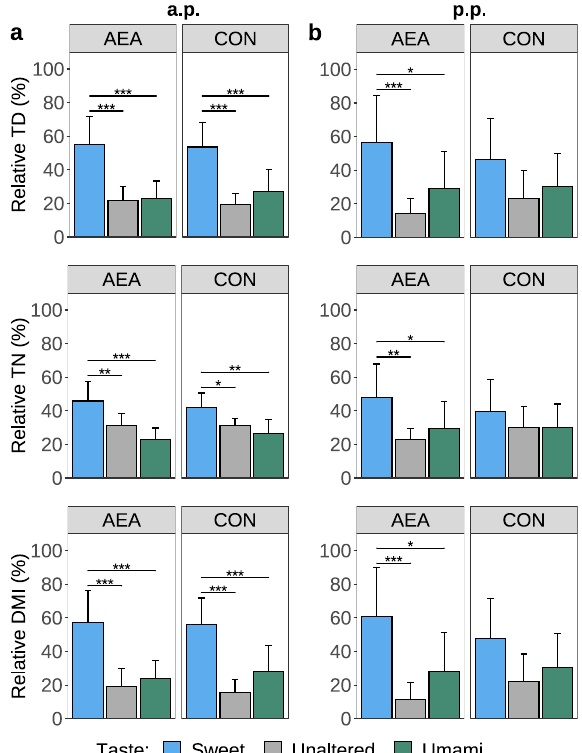
Figure 2. Three-day mean of percentage of total duration (TD) and total number (TN) of events the head entered the feeding bin, as well as dry matter intake (DMI) of the sweet and umami tasting or taste unaltered feed during the feed preference test ( a ) during the antepartum (a.p.) and ( b ) postpartum (p.p.) period. During the p.p. period, cows were treated intraperitoneally with NaCl (CON, n = 8) or N -arachidonoylethanolamide (AEA, n = 8). The mean of the observed data ± SD is shown for interpretation. * P < 0.05, ** P < 0.01, *** P <